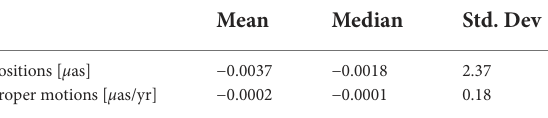
TABLE 1 Estimated reference frame tie errors (CSST-OS data to Gaia frame) per field for position and proper motion: mean, median, and standard deviation of the simulated